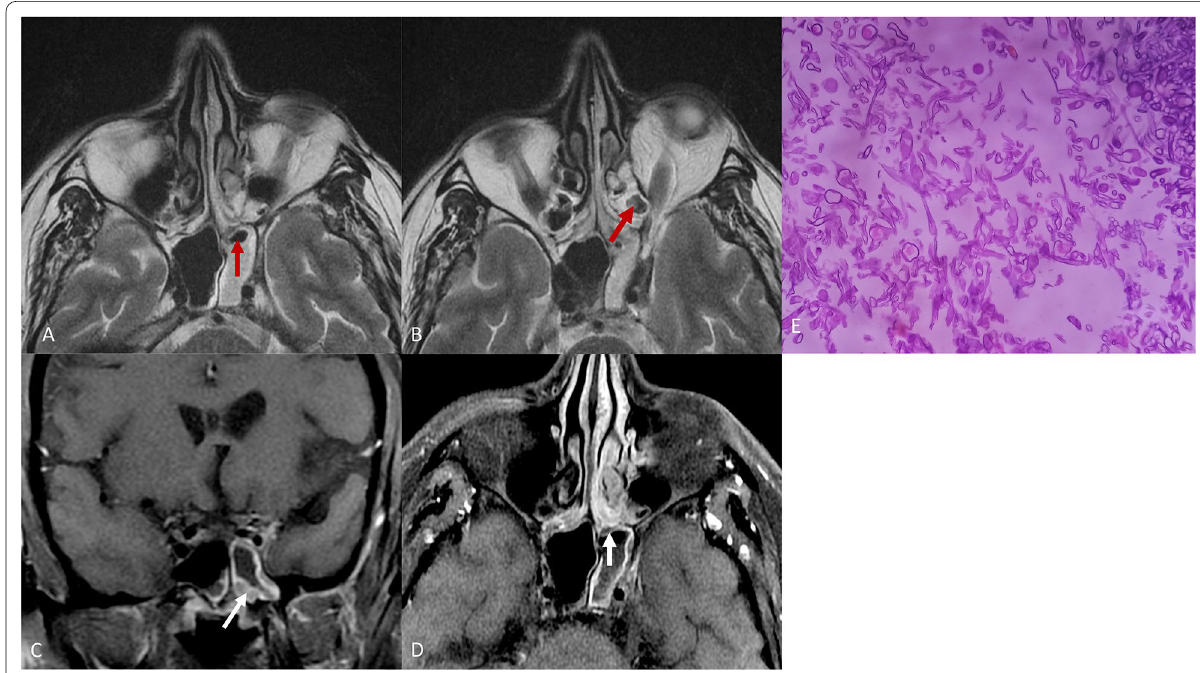
Fig. 6 (same patient as in Fig. 5: A , B : T2W axial images showing T2 hyperintense contents in ethmoid and sphenoid sinuses on left side with areas of signal void (red arrows) suggestive of fungal contents within. T1 post contrast coronal ( C ) and axial ( D ) images show patchy non-enhancing walls of sphenoid sinus on left side (white arrows) with normal enhancement of adjacent walls. E Microphotograph from debrided material showing magenta coloured aseptate fungal hyphae seen in the necrotic material likely to be mucormycosis (PAS stain X400)